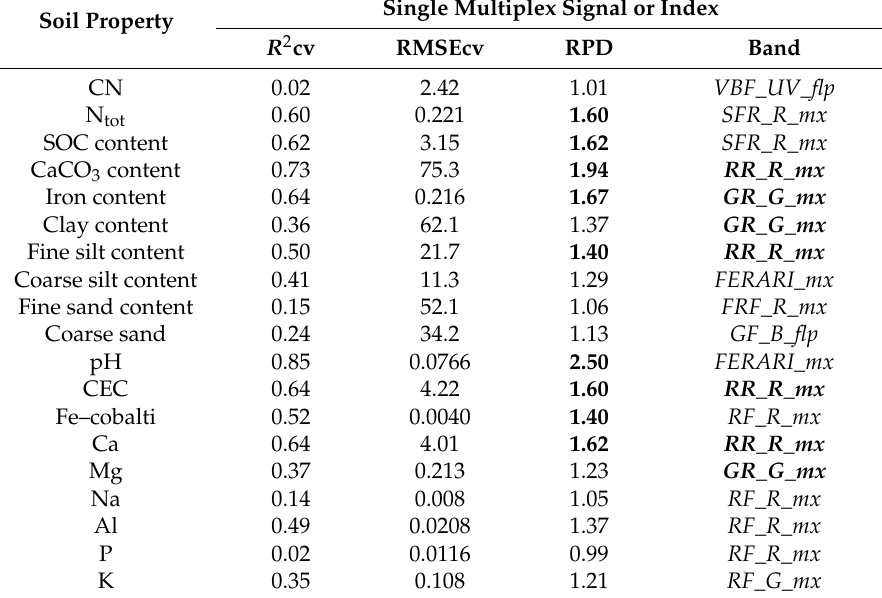
Table 9. Cross-validation performance statistics of simple linear regression from the best Multiplex signals for all horizons.